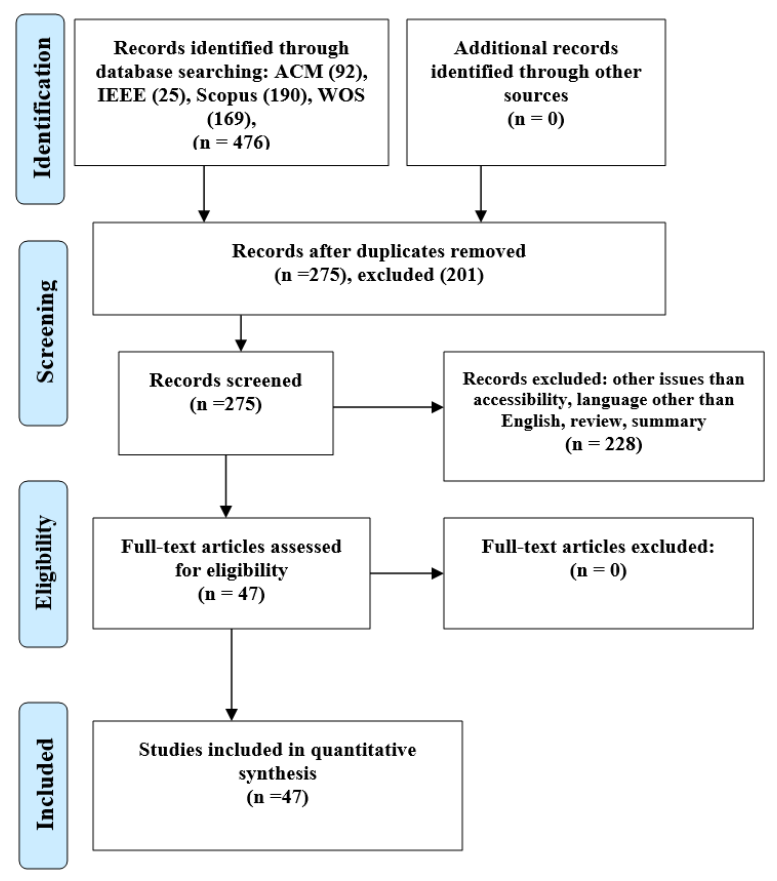
Figure 3. PRISMA flow diagram.